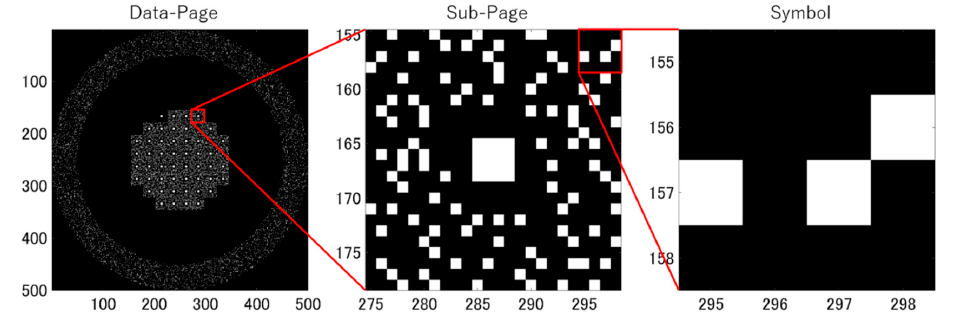
Figure 2. Original intensity pattern of signal pixels and reference pixels.